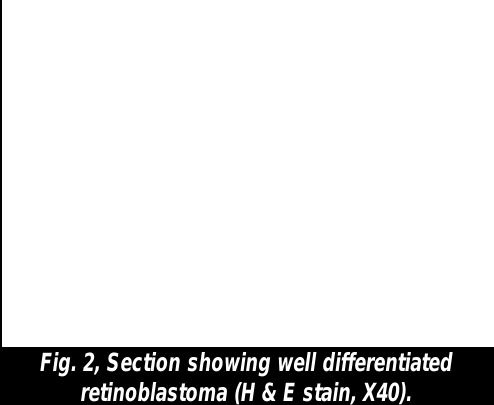
Fig. 2, Section showing well differentiated retinoblastoma (H & E stain, X40).